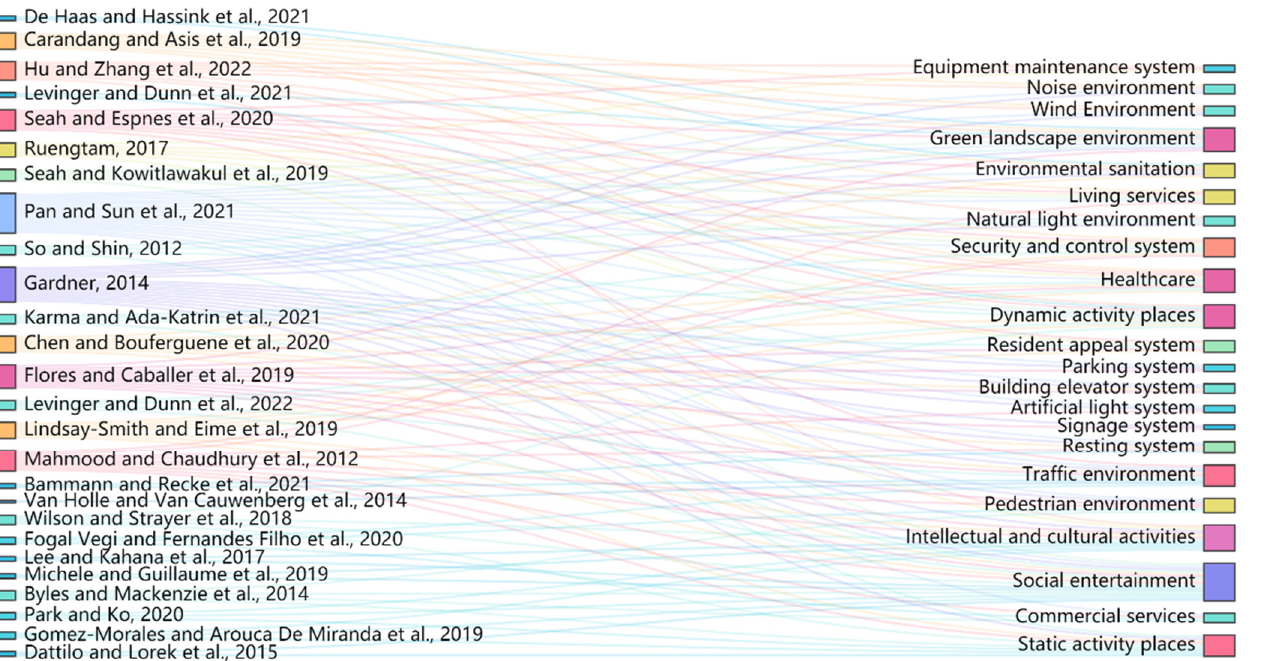
Figure 2. Correspondence between literature and indicators. Note: The left side of the Figure 2 shows the 26 articles [25–50] retrieved through the systematic literature review, and the right side shows the factors related to the evaluation of the suitability for older adults contained in these 26 articles.